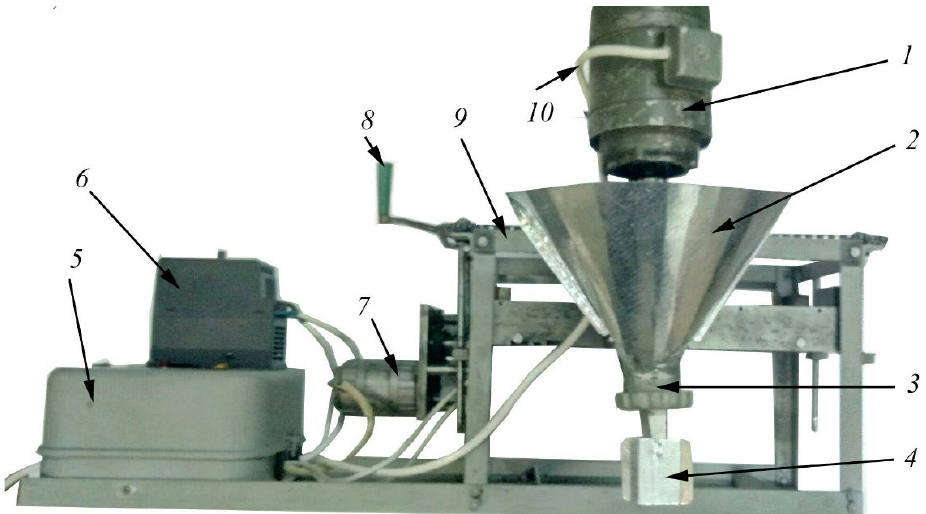
Figure 1. Laboratory 3D printer. 1—electric motor of the extruder; 2—hopper of building mixture; 3—auger; 4—mouthpiece; 5—control panel; 6—frequency converter of electricity; 7—reverse motor moving the extruder in the horizontal direction: 8—manual drive moving the extruder in the vertical direction; 9—frame; 10—power cable of electric